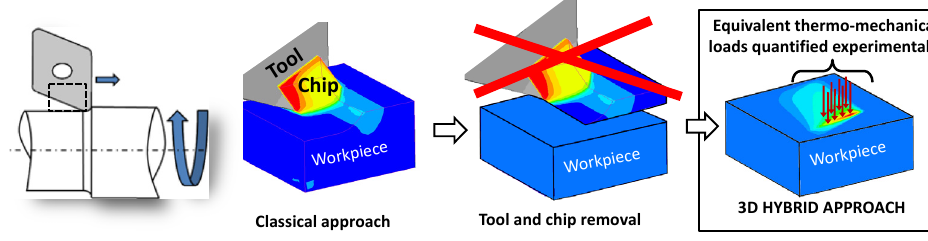
Figure 1. Principal of the 3D hybrid model [23].